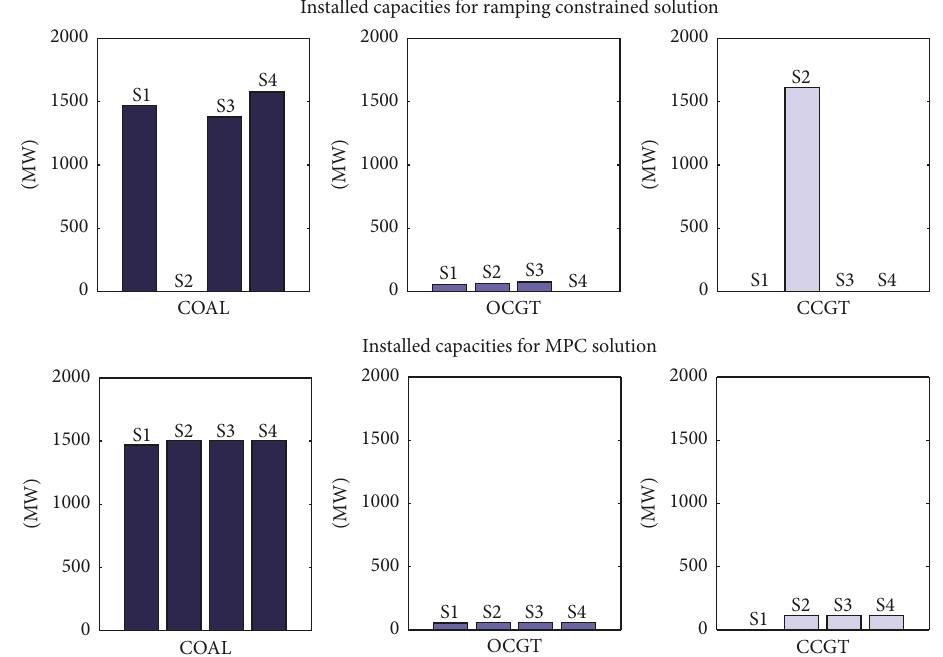
Figure 8: MPC solution: installed capacity for each scenario.